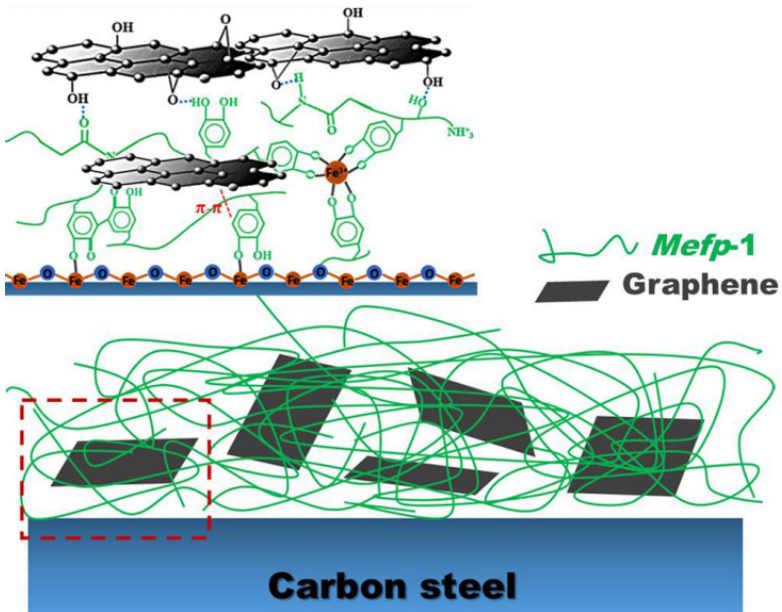
Figure 7. Schematic of the formation of Mefp -1/graphene composite film on carbon steel.